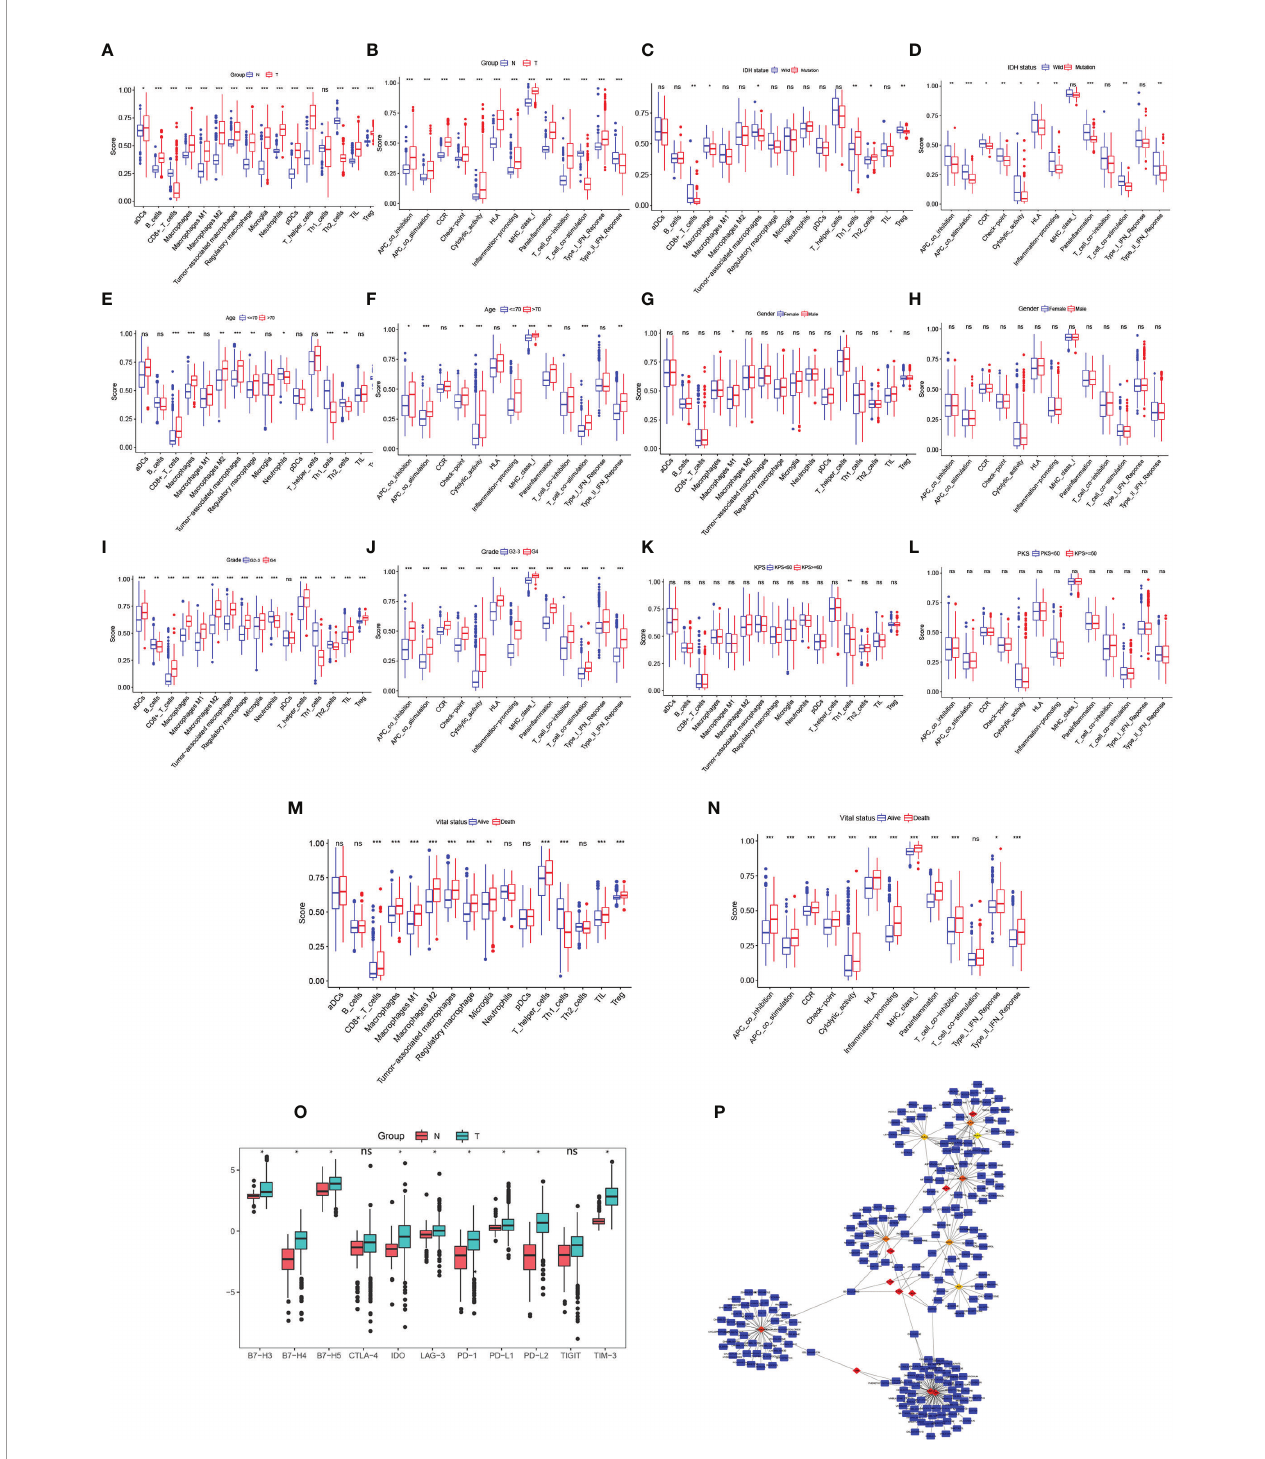
FIGURE 5 | Immune cell exploration in gliomas and small molecular drug prediction. (A, C, E, G, I, K, M) Glioma immune cell analysis using single-sample Gene Set Enrichment Analysis (ssGSEA). (B, D, F, H, J, L, N) Glioma immune cell function analysis using ssGSEA. (O) Immune checkpoint expression in glioma compared to in the normal brain. (P) Small molecular drug prediction targeting pivotal genes. *p < 0.05, **p < 0.01, ***p < 0.001. ns, no statistical